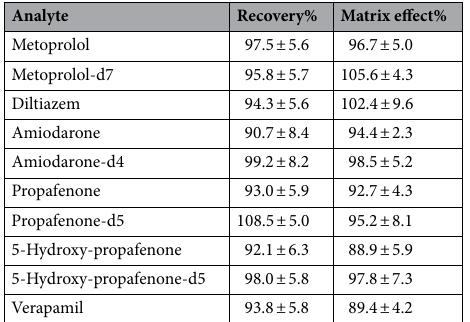
Table 5. Recovery and matrix effect of anti-arrhythmic compounds and internal standards in human serum.